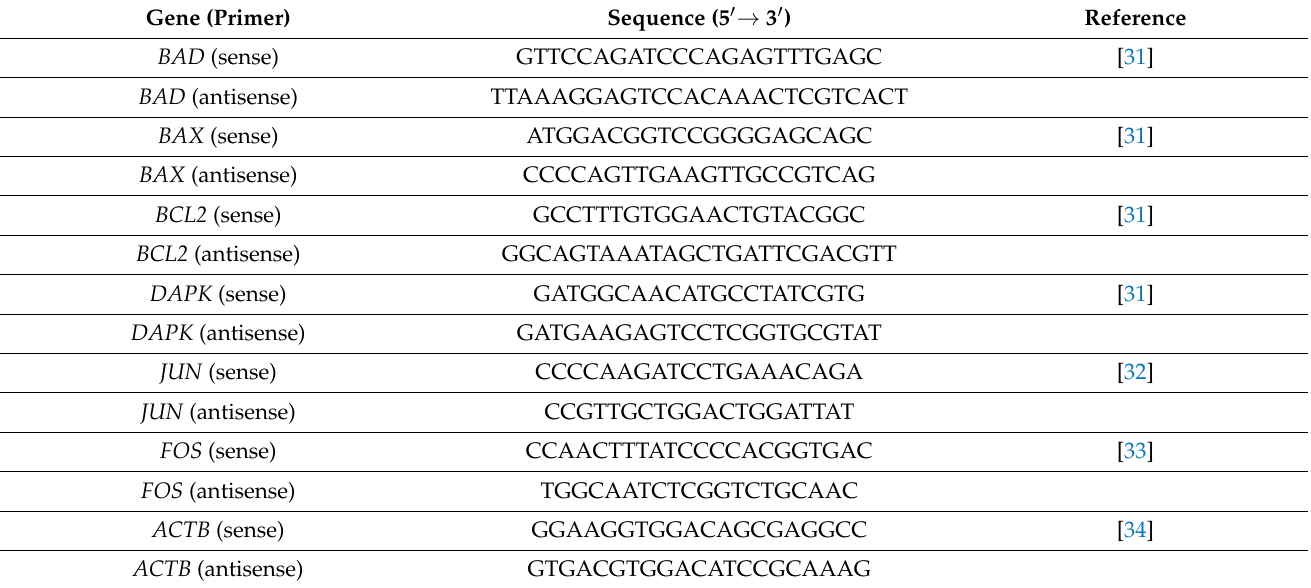
Table 1. Primers used for PCR amplification.